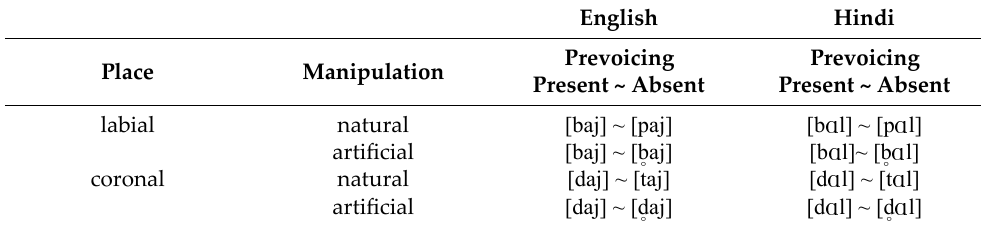
Table 3. The 8 pairs of target stimuli used in the main task, with each pair differing in the pres‑ ence/absence of prevoicing. Hindi coronal stops are all dental; the dental diacritic is omitted for readability. [b ] and [d ] refer to tokens where prevoicing has been artificially removed from natu‑ ˚ ˚ rally prevoiced tokens. An additional 8 pairs of stimuli differing in presence/absence of aspiration, not shown here, were also presented as fillers. English Hindi Prevoicing Prevoicing Place Manipulation Present ~ Absent Present ~ Absent